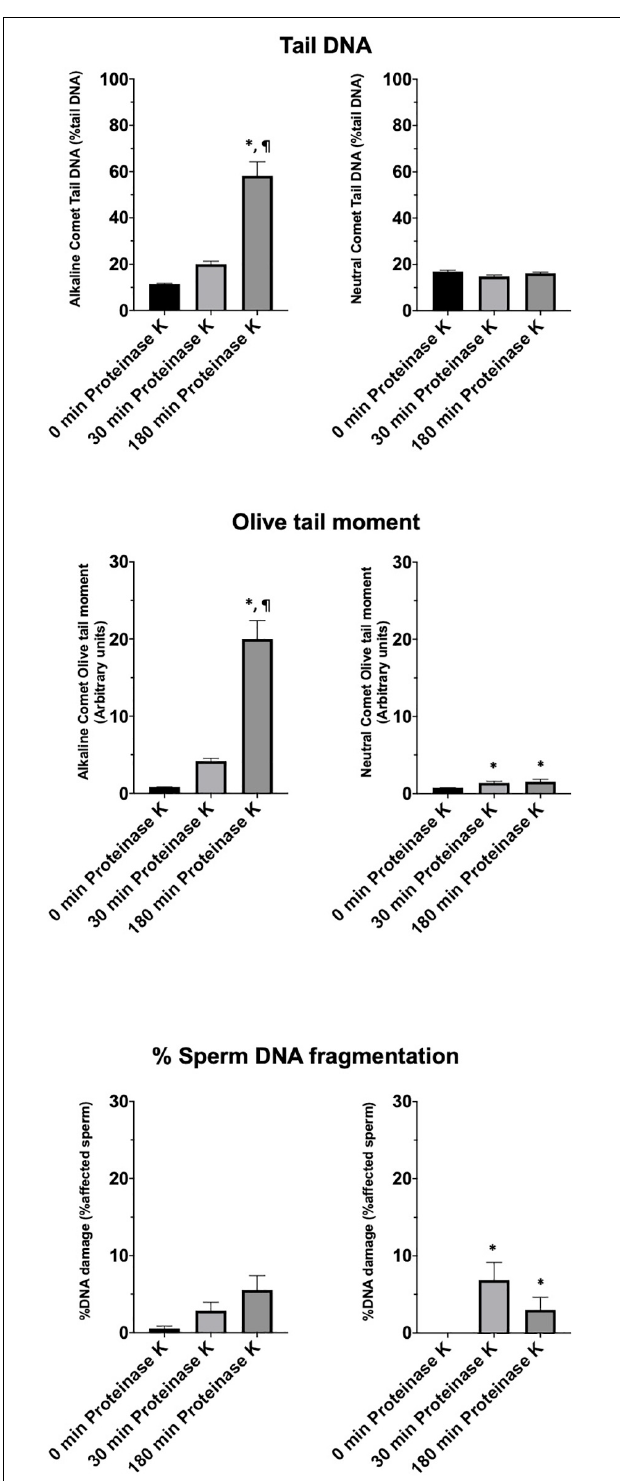
FIGURE 5 | Tail DNA, olive tail moment and percentage of affected sperm in 11 boars using alkaline and neutral Comet assays after different proteinase K treatments. ( ∗ ) Statistical differences compared to the similar treatment in 0 min of proteinase K ( P < 0.05). (¶) Statistical differences compared to the similar treatment in 30 min of proteinase K ( P <